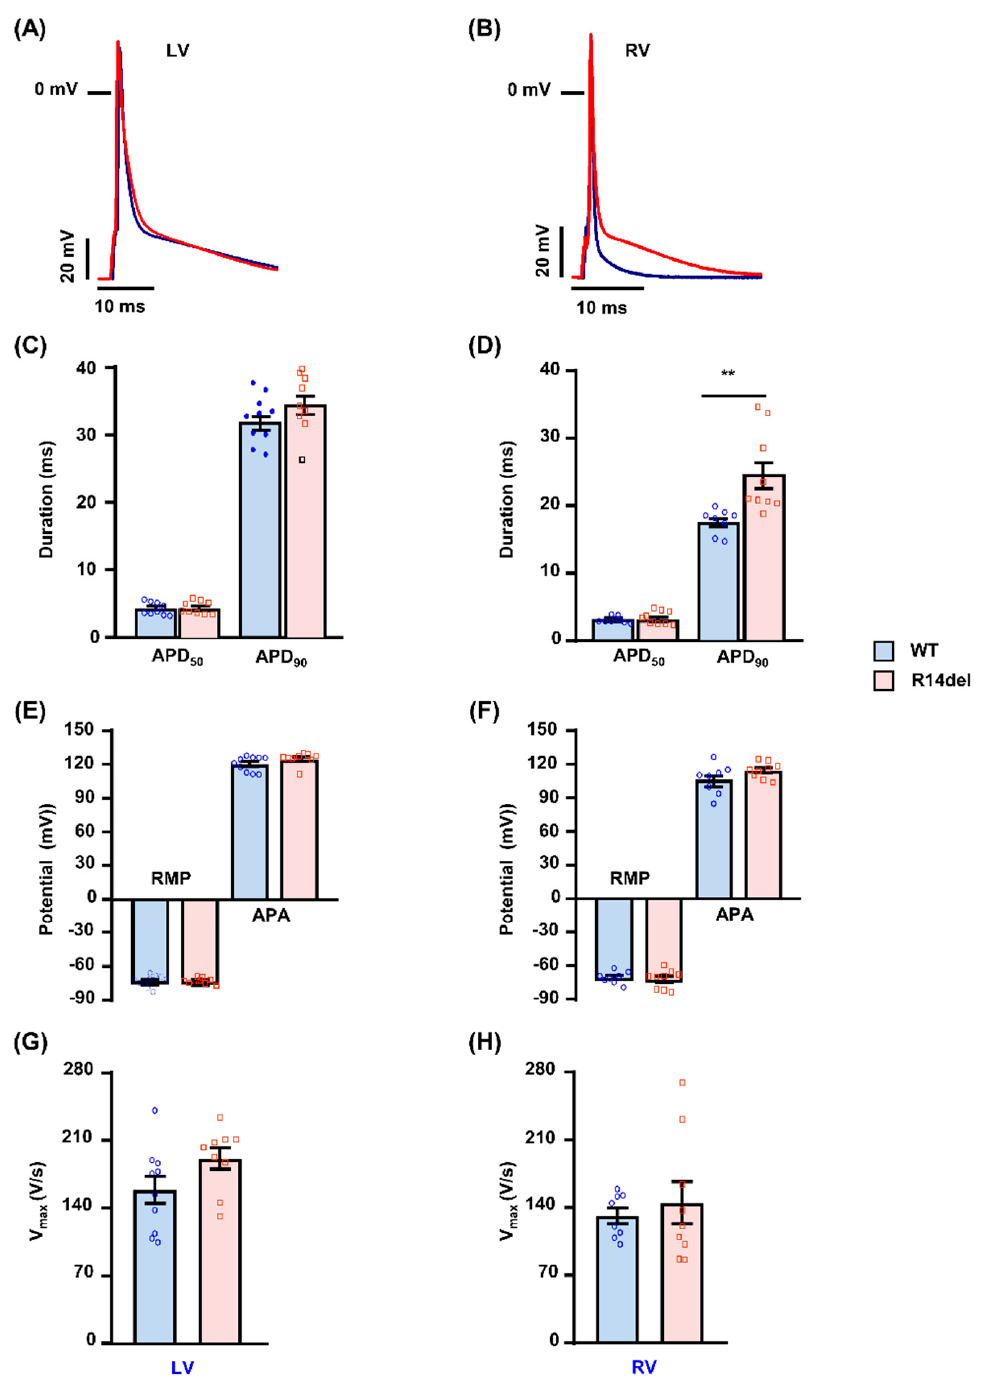
Figure 3. Action potential (AP) characteristics in cardiomyocytes from WT-PLN and R14del-PLN mice. APs were recorded in isolated LV and RV myocytes under basal conditions using whole-cell patch clamp recording under current clamp mode at room temperature. ( A , B ) Representative traces of action potential (AP) measured at 1 Hz. ( C , D ) Average AP duration (APD) at APD 50 and APD 90 repolarization. ( E , F ) Average resting membrane potential (RMP) and AP amplitude (APA). ( G , H ) Average maximal upstroke velocity (Vmax). n = 8 cells for LV and n = 10 cells for RV of WT (N = 3 hearts) and n = 9 cells for LV and n = 9 cells for RV of R14del-PLN (N = 3 hearts). Data are expressed as mean ± SEM of the total number of cells/group and statistical analyses were performed by Student’s unpaired t -test. ** p ≤ 0.001 vs. WT-PLN.